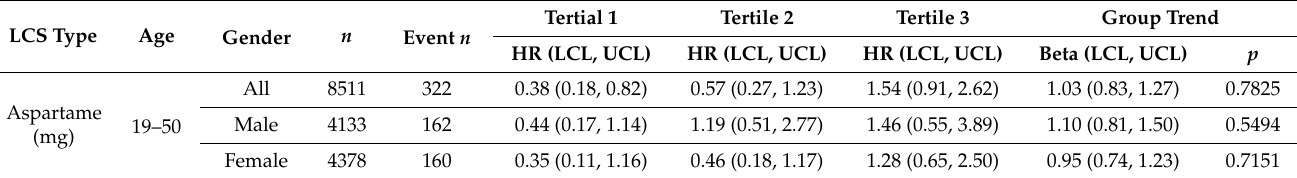
Table 5. Cancer mortality hazard ratio (HR) associations with aspartame and saccharin consumption tertiles, 1988–1994. Data are hazard ratios (HR) and 95th percentile confidence lower (LCL) and upper (UCL) levels. Cox proportional hazards regression was used to estimate HR and 95th percentile confidence levels for cancer mortality. HRs were estimated by assigning nonconsumers of aspar- tame/saccharin/LCS to the reference group (HR = 1.0). LCS consumers were then split by tertiles of consumption T1, T2, and T3, using SAS 9.4 PROC SURVEYPHREG with age, sex, race/ethnicity, education, current smoking status (Y/N), alcohol consumption, physical activity level, and BMI (continuous) as covariates. Data adjusted for complex sample design of NHANES and used relevant sample